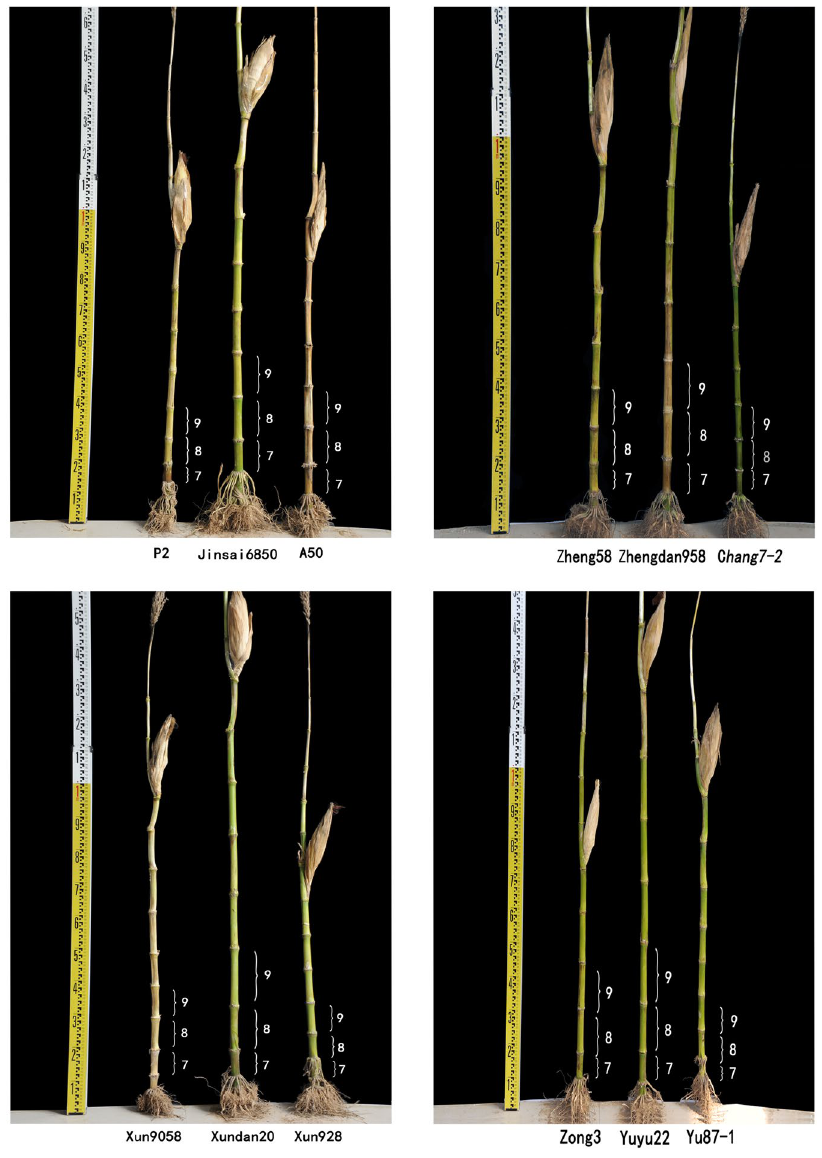
Figure 1. Trait performance and mid-parent heterosis in four hybrids.